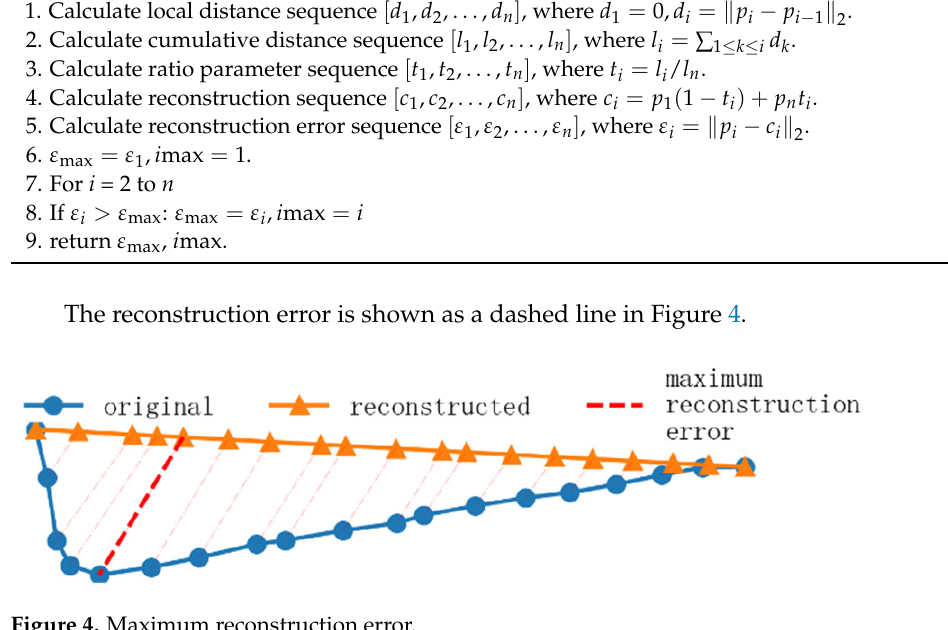
Figure 4. Maximum reconstruction error. Based on the maximum reconstruction error, the process for separating straight-line segments of a continuous trajectory TS with m sampling points is as